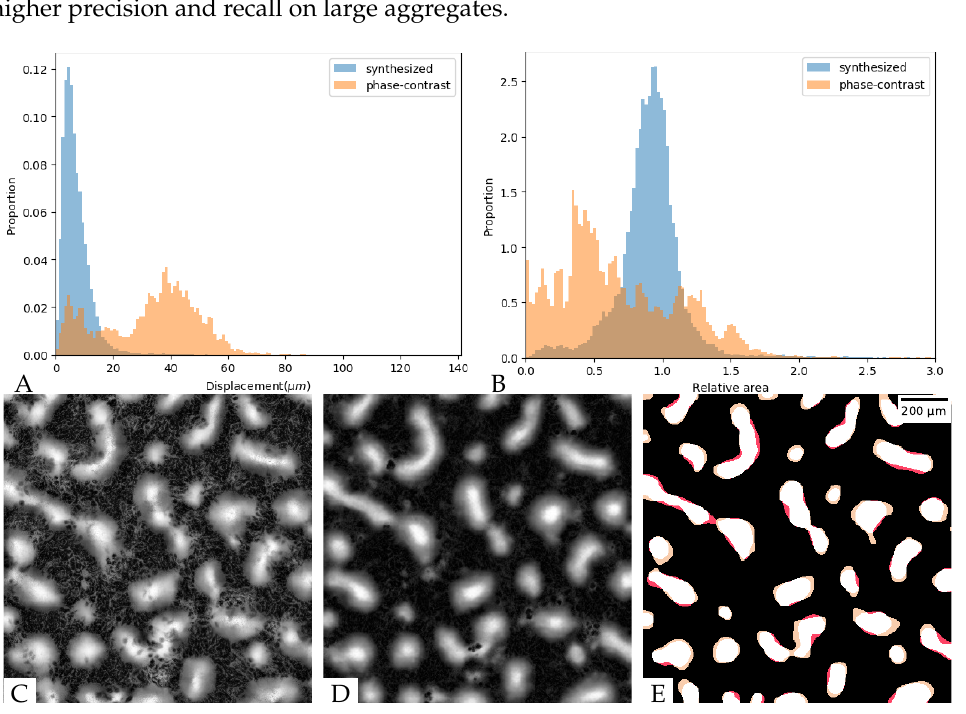
Figure 6. Aggregate segmentation for images of 1 × 10 10 cells/mL cell density. ( A ) The distribution of distances between centroid positions; blue—real and synthesized fluorescent images; orange—phase- contrast and real fluorescent images. ( B ) The distribution of area ratios for the matched aggregate pairs; blue—real and synthesized fluorescent images; orange—phase-contrast and real fluorescent images. ( C ) Fluorescent image at the 800 min. ( D ) Synthesized image at the 800 min. ( E ) Aggregate segmentation result at the 800 min; white—true positive, black—true negative, yellow—false positive, red—false